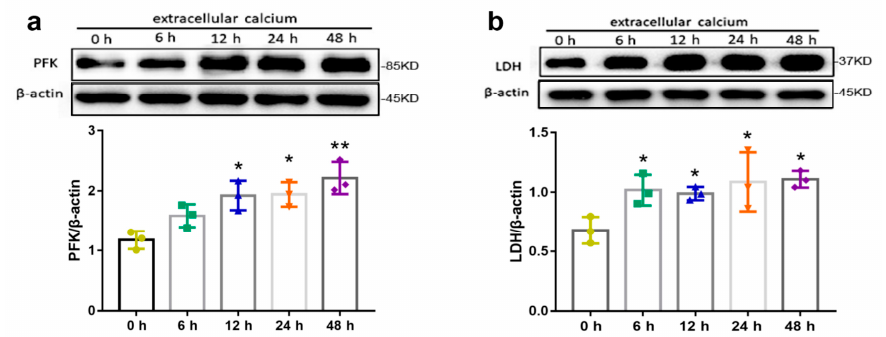
Figure 4. Effects of extracellular 7.2 mM Ca 2+ on levels of metabolism enzymes. ( a ) PFK and ( b ) LDH. * p < 0.05, ** p < 0.01, vs. 0 h.